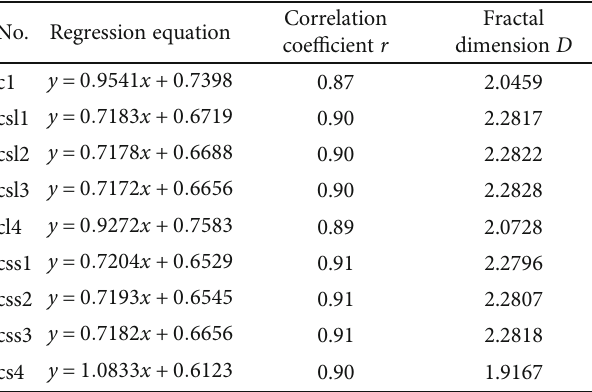
Table 3: Fractal dimensions of particle size distributions and corresponding regression